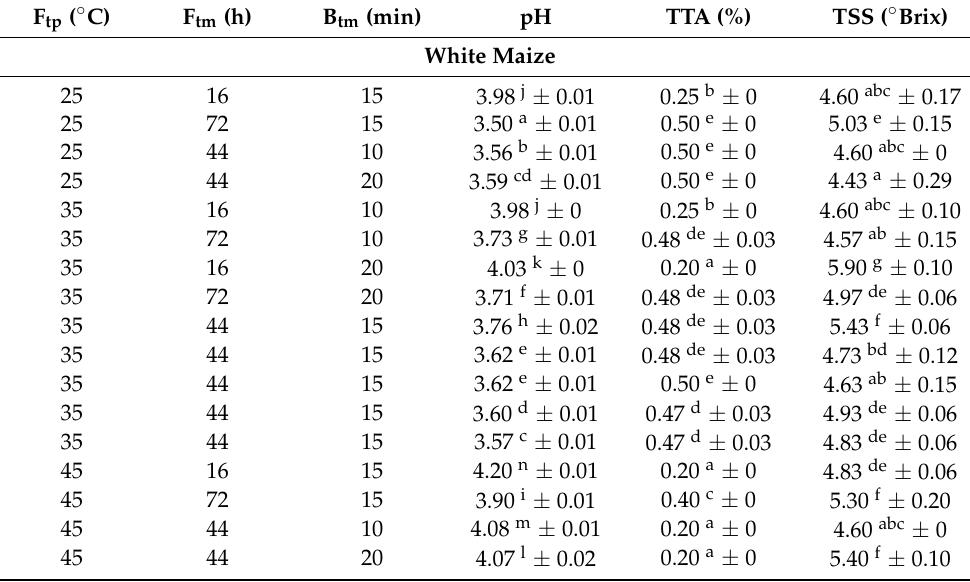
Table 2. pH, TTA and TSS results of the mahewu